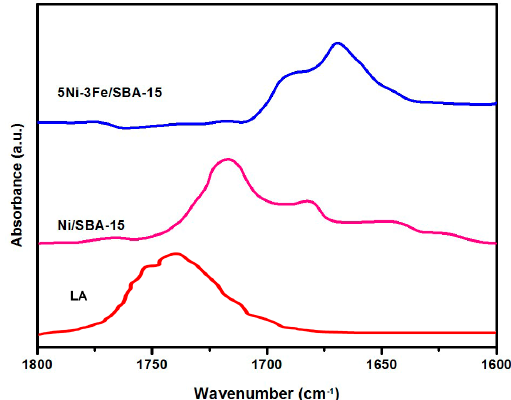
Figure 4. In situ FT-IR (Fourier transform–infrared spectroscopy) spectrum of LA and LA absorption on Ni/SBA-15 and 5Ni-3Fe/SBA-15 (50 mL ∙ min − 1 He, at 200 °C, 2 h).